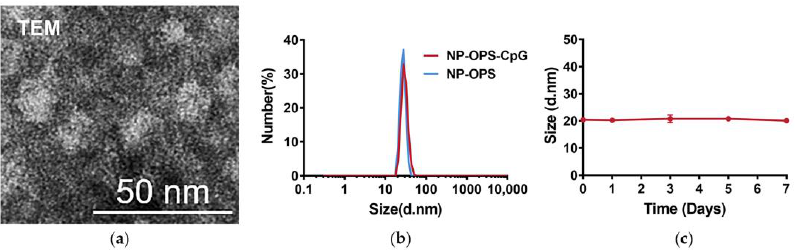
Figure 2. Characterization and stability of NP-OPS-CpG. ( a ) TEM images of NP-OPS-CpG. ( b ) DLS analysis of NP-OPS and NP-OPS-CpG separately, showing that the nanoparticles were about 25 – 50 nm in diameter. ( c ) Stability of the NP-OPS-CpG diameter after being stored at 37 °C for 7 days. The diameter of NP-OPS-CpG was analyzed by DLS (n = 3).